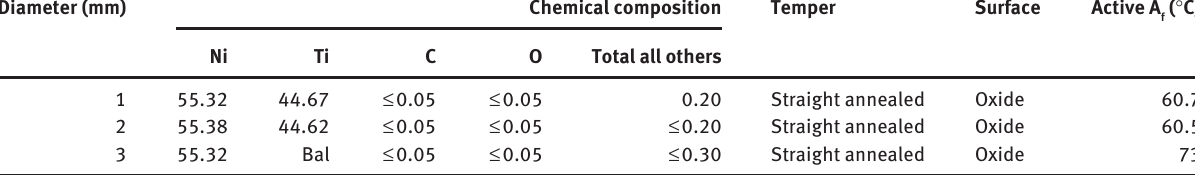
Table 1 Shape memory alloy material